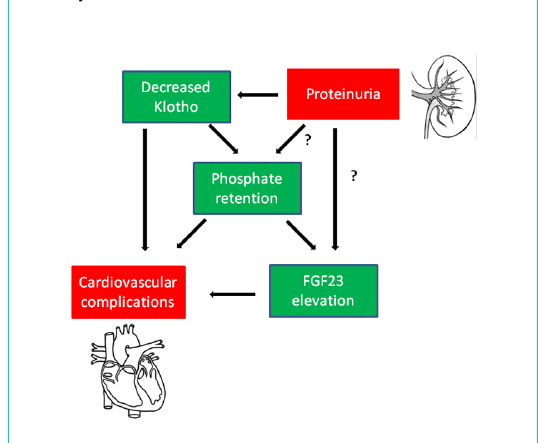
Figure 1: Pathway by which proteinuria increases cardiovascular mortality.